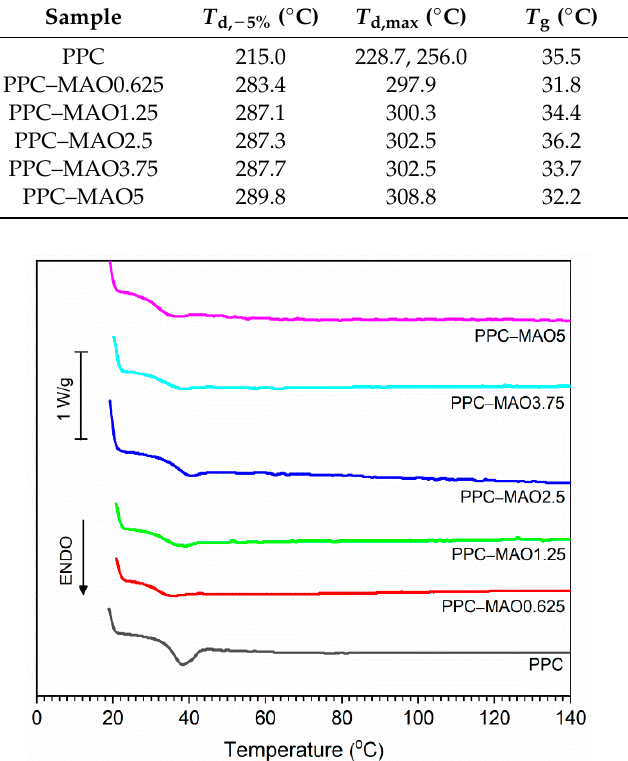
Figure 2. The differential scanning calorimetry (DSC) curves for PPC and PPC–MAO with networks.